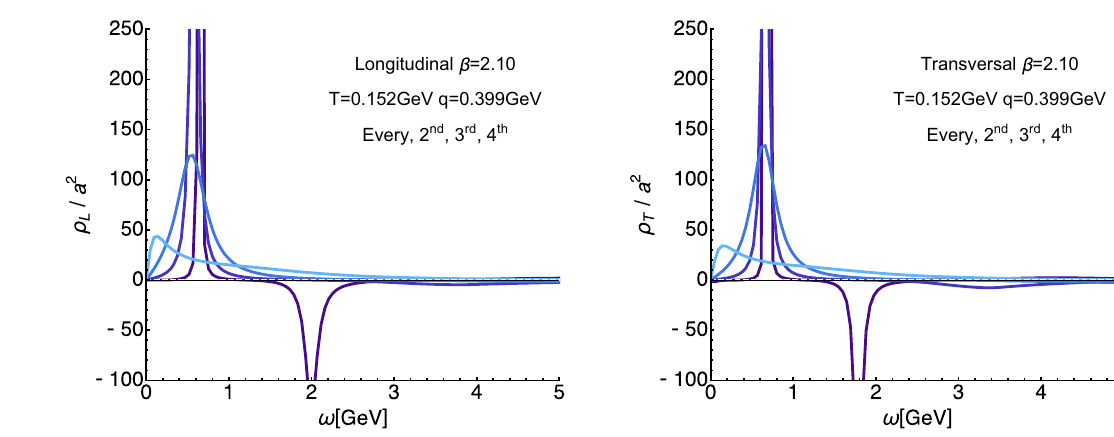
Fig. 9 Systematic uncertainties of the spectral reconstruction in a frequency (dark to light colors). These thinned out correlators corre- spond to the reconstructed correlator [60] at higher temperature. Clear fixed-scale approach for the longitudinal (left) and transversal (right) changes in the overall features of the reconstructed spectra are visible, sector at β = 2 . 10. We show the spectral functions extracted from the in particular the negative trough is much more weakly resolved. The correlator at the smallest available | q | and lowest T = 0 . 152 GeV, i.e. / 2 = 10 of resolved imaginary position of the first peak, however, remains relatively stable down to the dataset with the largest number N q 4 / 2 = 4, in particular in the transversal N q frequencies (dark blue). The lighter blue solid curves denote the results 4 from a sparsened dataset, using only every 2nd, 3rd or 4th imaginary